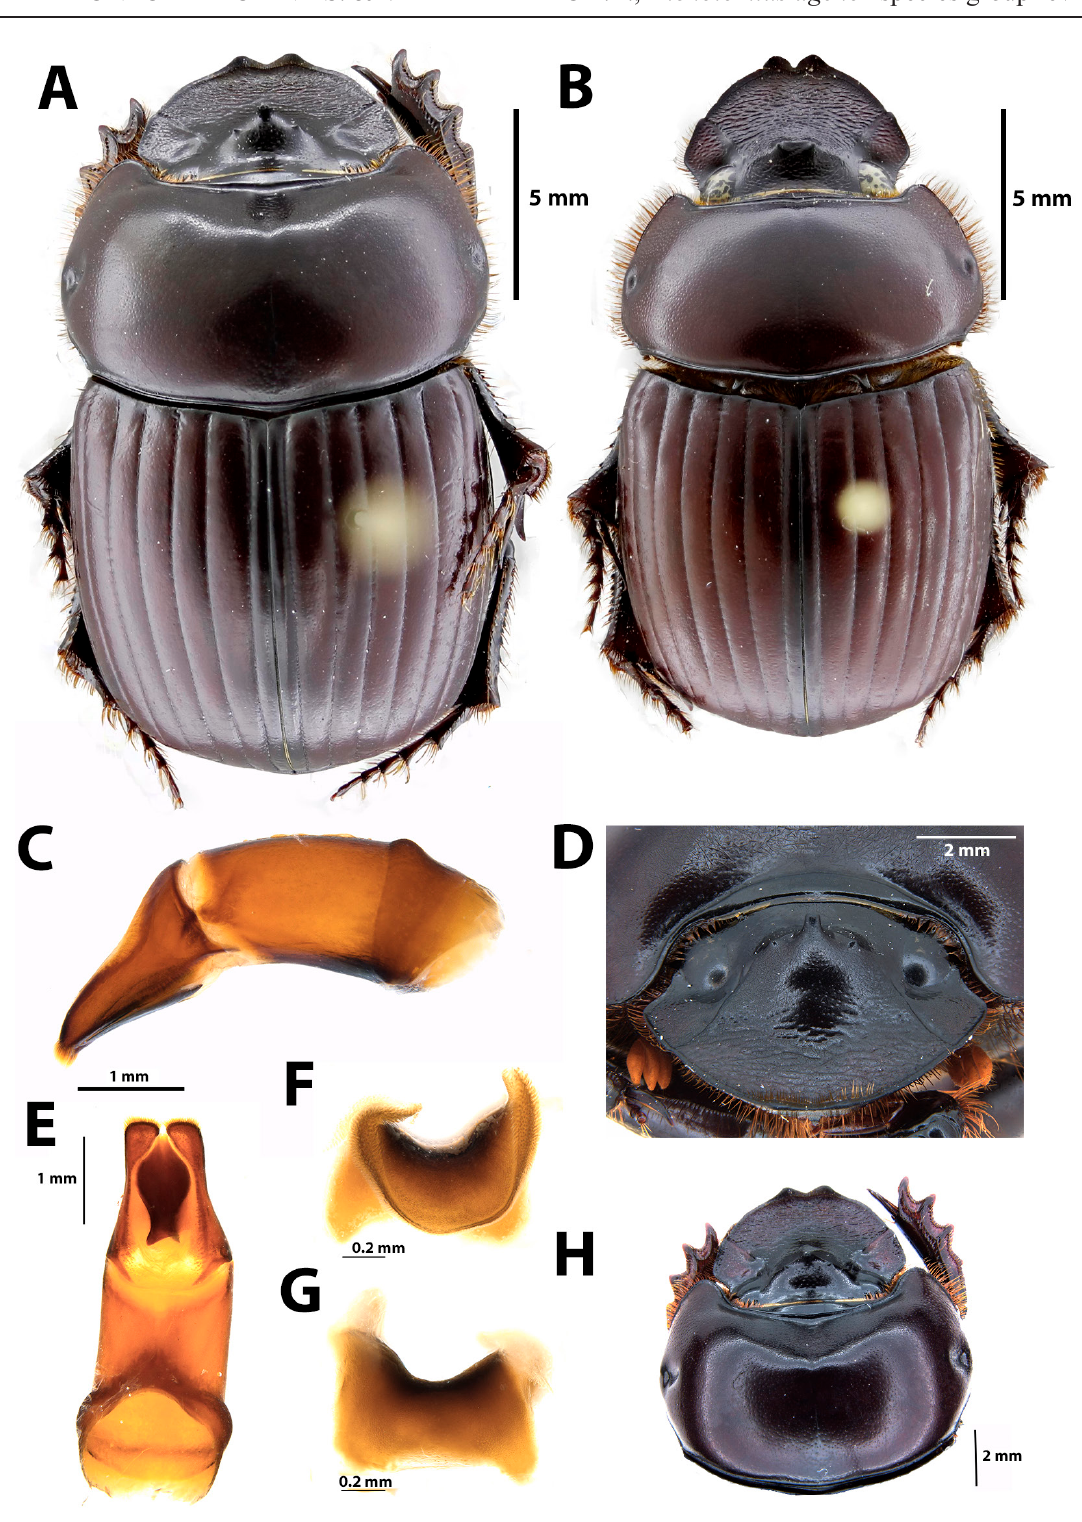
Fig. 14. Dichotomius simplicicornis (Luederwaldt, 1935). A–B . Dorsal habitus. A . ♂. B . ♀. C . Lateral view of the aedeagus. D . Frontal view of the male head, cephalic carina apically rounded, emarginate, lateral tubercles short and acute on the apex. E . Ventral view of the aedeagus. F–G . Lamella copulatrix. H . Pronotum arcuate viewed from above, anterior edge declivity resembling two under-developed lobes at the